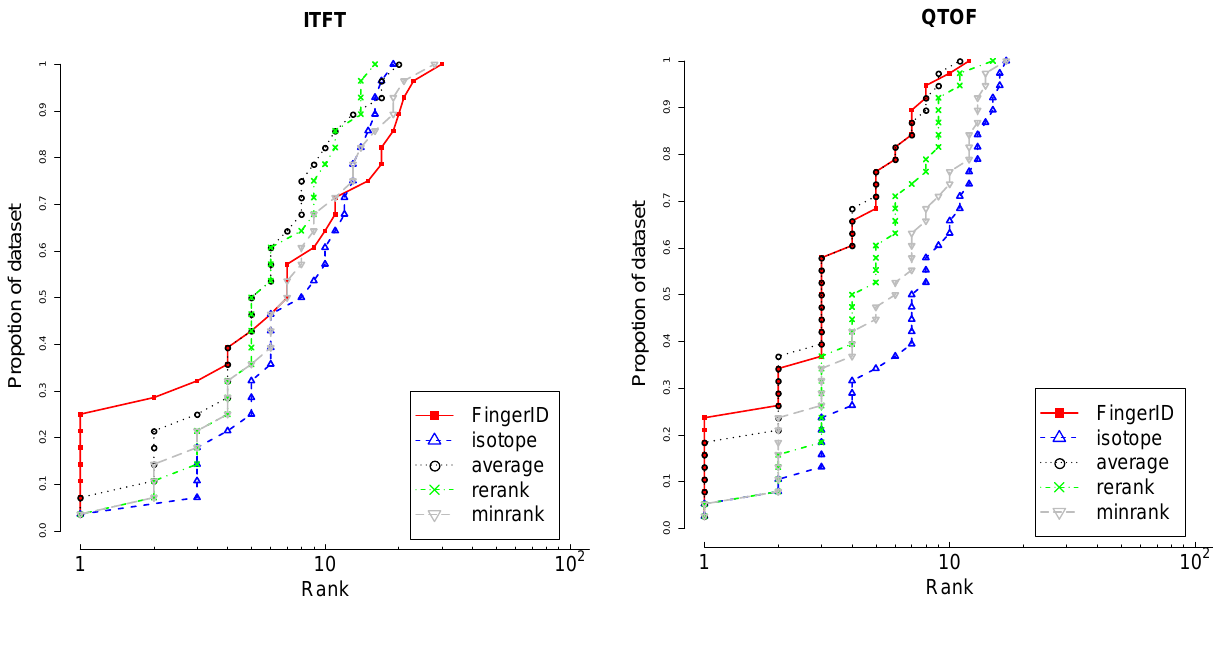
Figure 8. The rank distribution of metabolites using FingerID alone, isotope matching alone and the different rank aggregation schemes; average rank, minrank and rerank. The higher the curve, the larger the proportion of highly ranked molecules. The x-axis is in log scale. ITFT